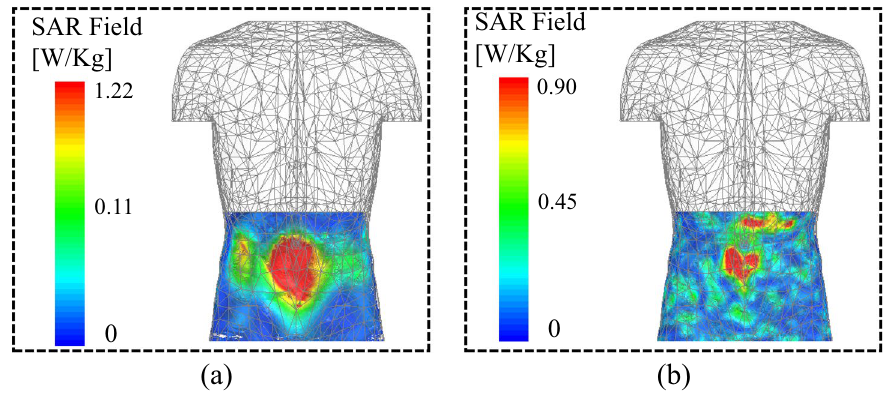
Figure 17. Specific absorption rate of the WPT system at ( a ) 0.915 GHz, and ( b ) 2.45